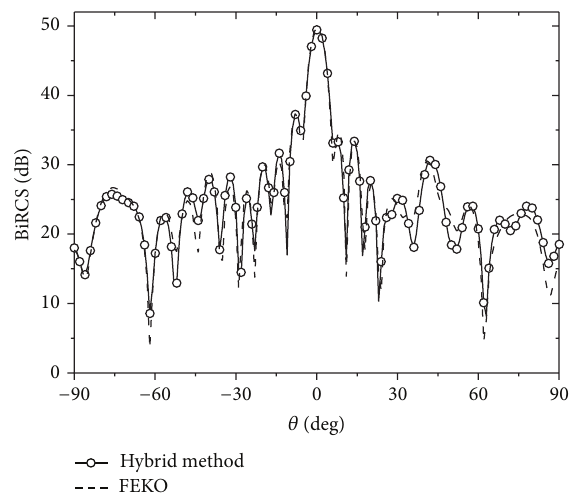
Figure 4: BiRCSs of the dielectric group on a large PEC platform. direction. The distance between adjacent dielectric elements is 0.5𝜆 . In the implementation of the conventional MoM for discretization, each dielectric element is meshed into 782 RWGs and the PEC plate is meshed into 3544